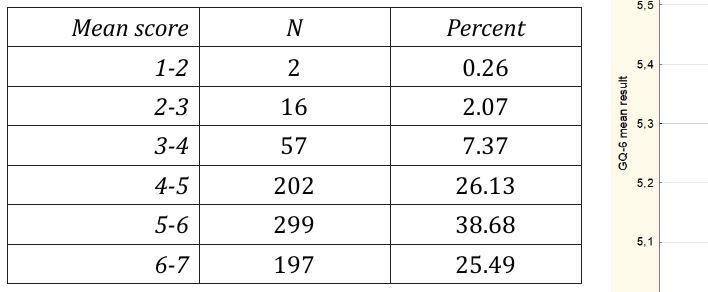
Table 5. The mean results of The Gratitude Questionnaire – Six Item Form.